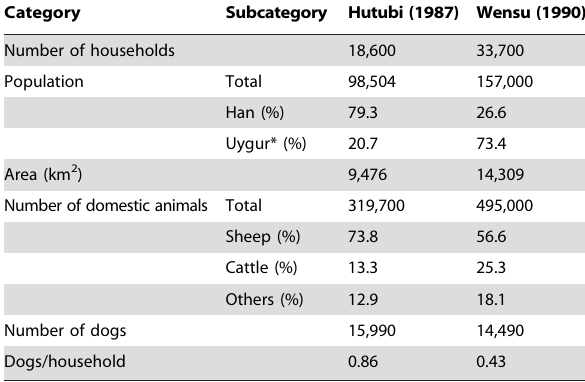
Table 1. General information about the two counties selected for the pilot control program in Xinjiang.